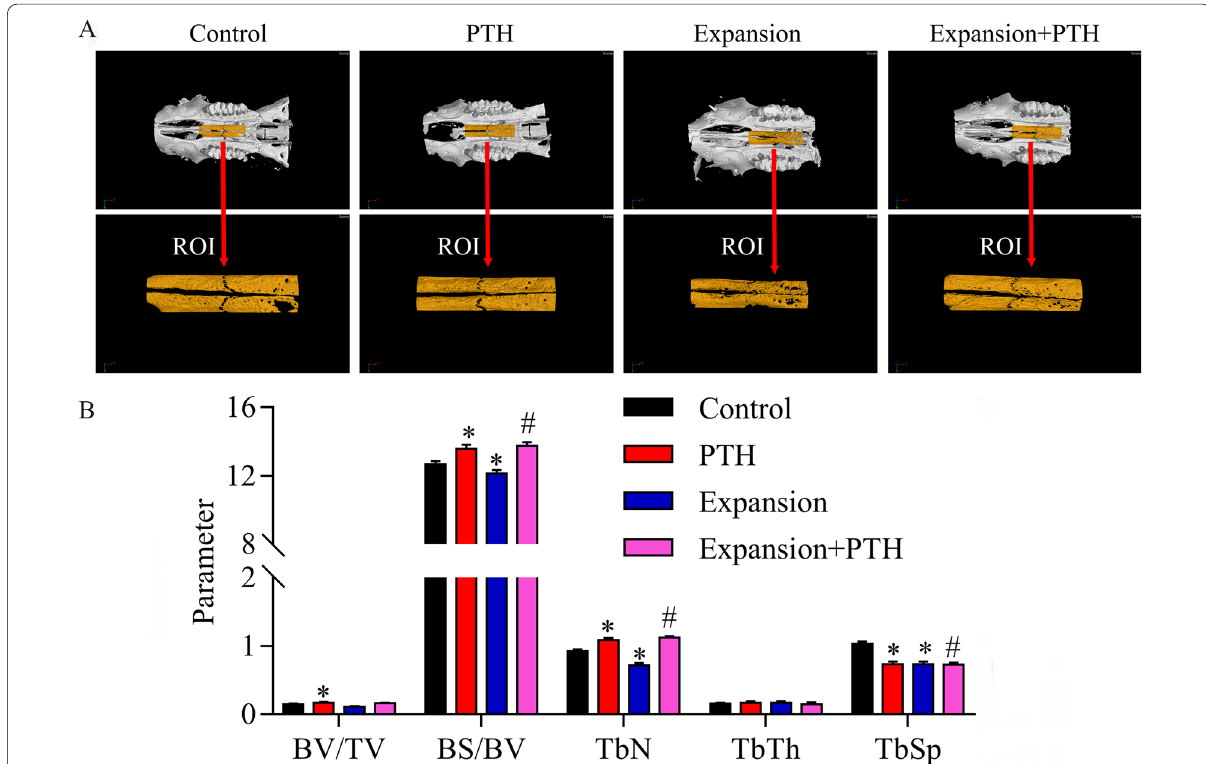
Fig. 5 PTH accelerated maxillary reconstruction of maxillary expansion model rats. The rats were divided into control, PTH, expansion and expansion PTH groups, respectively. A The bone rebuilding of maxillary expansion model rats was determined using microCT method. B The BV/ + TV, BS/BV, TbN, Tb.Th and Tb.Sp were quantized, respectively. * P < 0.05 versus control group; # P < 0.05 versus expansion group. BV/TV, trabecular bone volume fraction; BS/BV, smaller specific bone surface; TbN, trabecular number; Tb.Th, trabecular thickness; Tb.Sp, trabecular separation